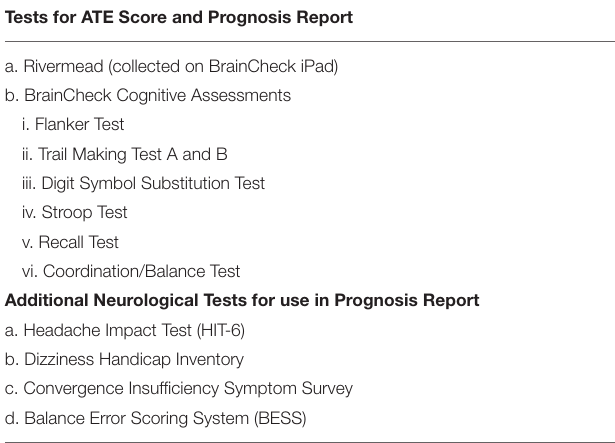
TABLE 1 | Inclusion and exclusion criteria. TABLE 2 | Neuropsychiatric/neurocognitive testing